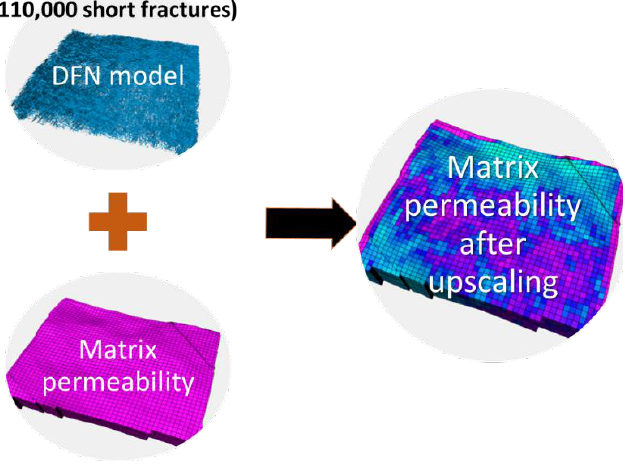
Figure 20. Scheme of the process for upscaling 110,000 well-connected fractures into the matrix.